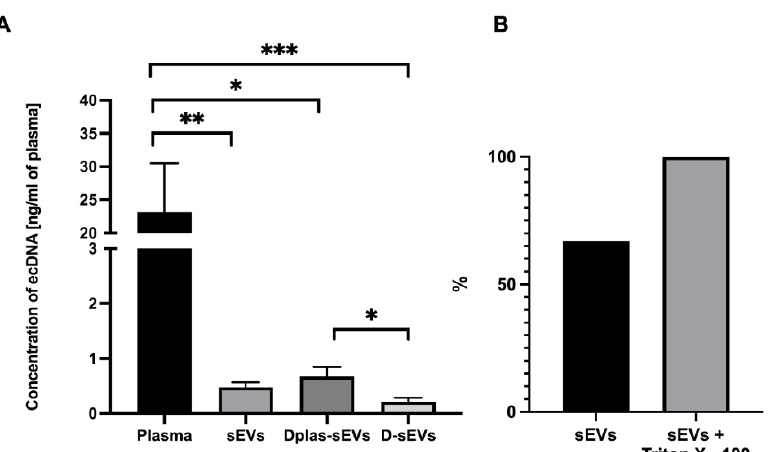
Figure 4. EcDNA in plasma and sEVs. ( A ) Quantification of ecDNA in plasma and sEVs. ( B ) Per- centage of ecDNA outside of sEVs. Percentage shows the average concentration of DNA. sEVs–sEVs isolated from non-treated plasma, Dplas-sEVs–sEVs isolated from DNase-treated plasma and D-sEVs– sEVs treated with DNase. * p ≤ 0.05; ** p ≤ 0.01; *** p ≤ 0.001; data are shown as the mean ± SEM.